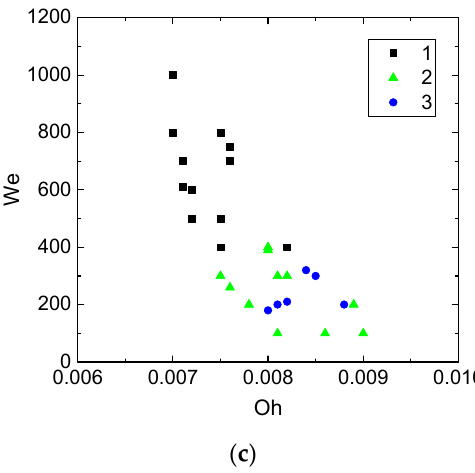
Figure 11. Interaction regime maps considering inertia, friction, surface tension, and viscosity in accordance with the data: ( a ) [44]: 1, 2—the dashed blue and purple lines are extensions of the expressions over the phase diagram (for interpretation of the references to color in this figure legend, the reader is referred to the web version of this article); 3, 4—moreover, in the splashing regime, red dots correspond to impact with the appearance of a lifted thin film and black dots to impact creating satellite droplets; 5—each type of marker represents a different behavior of the droplet; 6—asterisks stand for the deposition impact, dots for a splashing impact, and crosses for an impact with the appearance of a gas cushion during the transition period; ( b , c ) generalization of the experimental results [33]: 1—coalescence; 2—separation; 3—disruption.